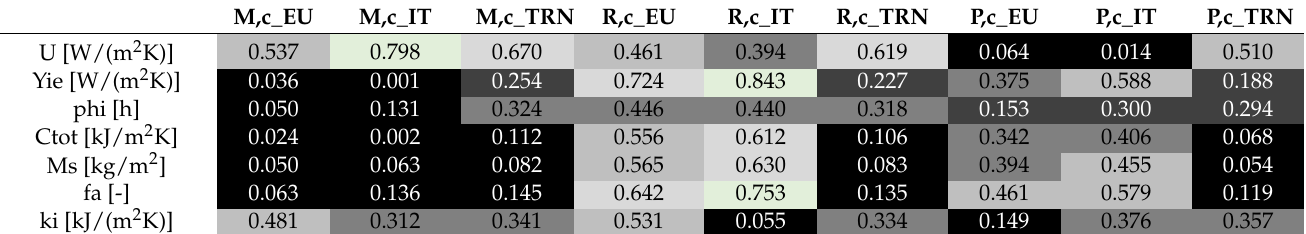
Table A5. Weight analysis of the thermo-physical attributes of opaque structures, for the summer period and with g gl =